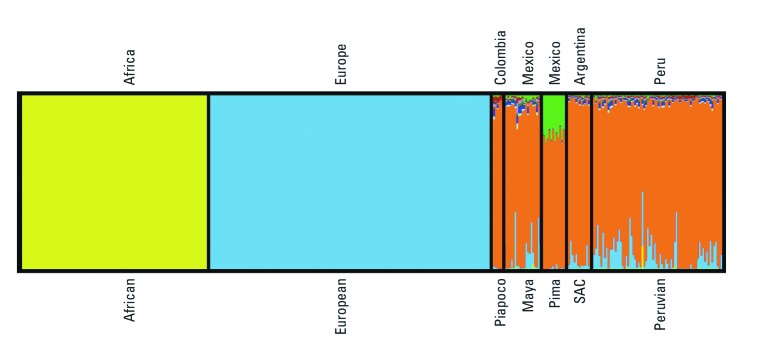
Supervised clustering of groups from SAC, Peru, and HGDP groups. Clustering at K = 10 clusters are shown. African and European participants from the HGDP panel were predefined as reference groups for the “yellow” and the “blue” clusters, respectively, in order to determine the European and African admixture levels among the Native American populations. The remaining variation belongs to the main Native American cluster (orange). The Pima showed partial contribution from another group (green) compared with the SAC and the Peruvian populations for K = 7 to K = 10. Each individual is represented by a vertical line divided into K colors, with each color representing a cluster. Each different population is separated by a black line and labeled by population and location.